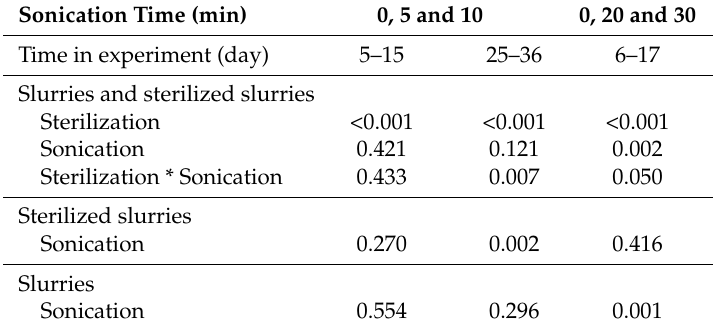
Table 1. The two factor (sonication, sterilization) repeated measures analysis of variance (RMA) of atrazine concentrations in the slurries and sterilized slurries, both sonicated for 0, 5, 10, 20, or 30 min ( n = 3). Sonications were done once a day on days 5–15, and twice a day on days 25–36 and 6–17. The p -values of between subject effects are